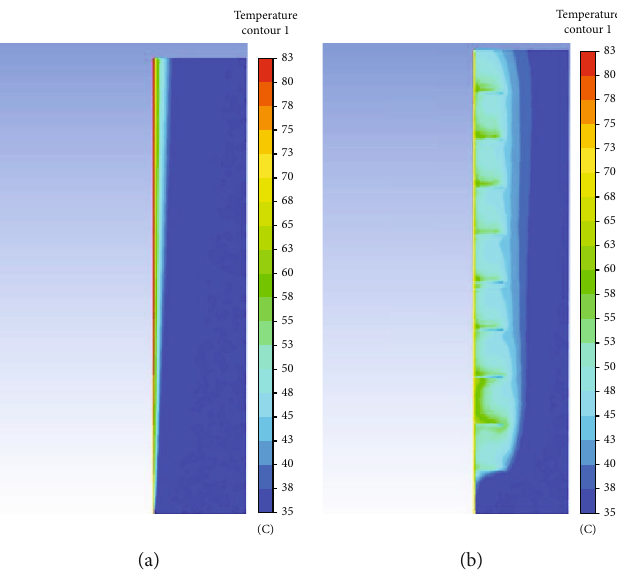
Figure 4: Thermal contour of PV panels (a) without aluminum heat sinks and (b) with aluminum heat sinks.